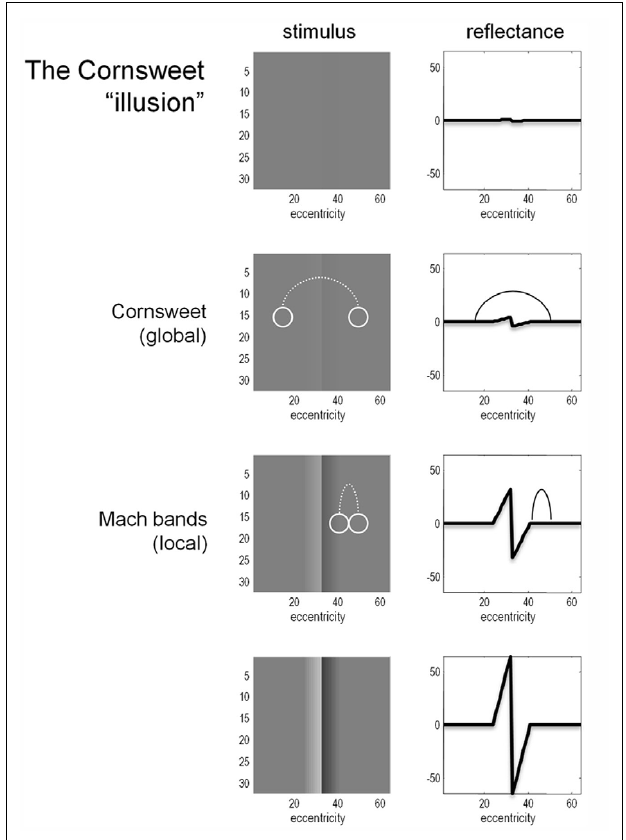
FIGURE 1 |The Cornsweet illusion and Mach bands. The Cornsweet illusion is the false perception that the peripheral regions of a Cornsweet stimulus have different reflectance values.The magnitude of the effect increases as the contrast of the stimulus increases. At higher levels of contrast, the secondary illusion – Mach bands – appear.The Mach bands are situated at the point of inflection of the luminance gradient.